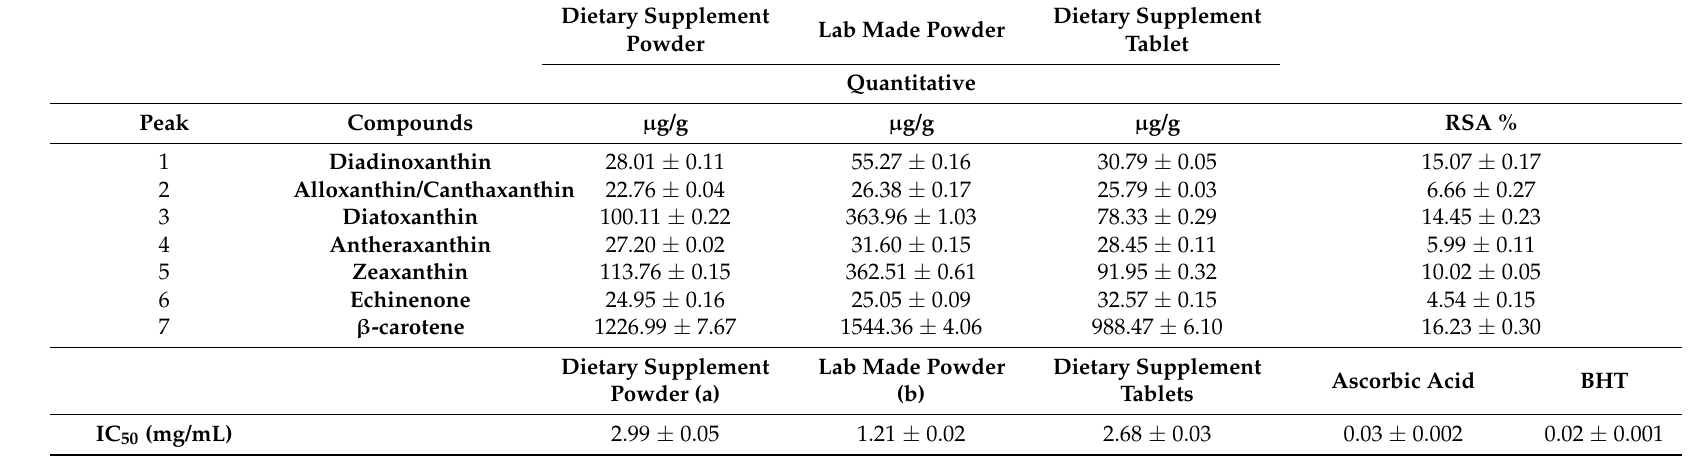
Table 2. Quantitative data, RSA% of single compounds and IC 50 of different dietary